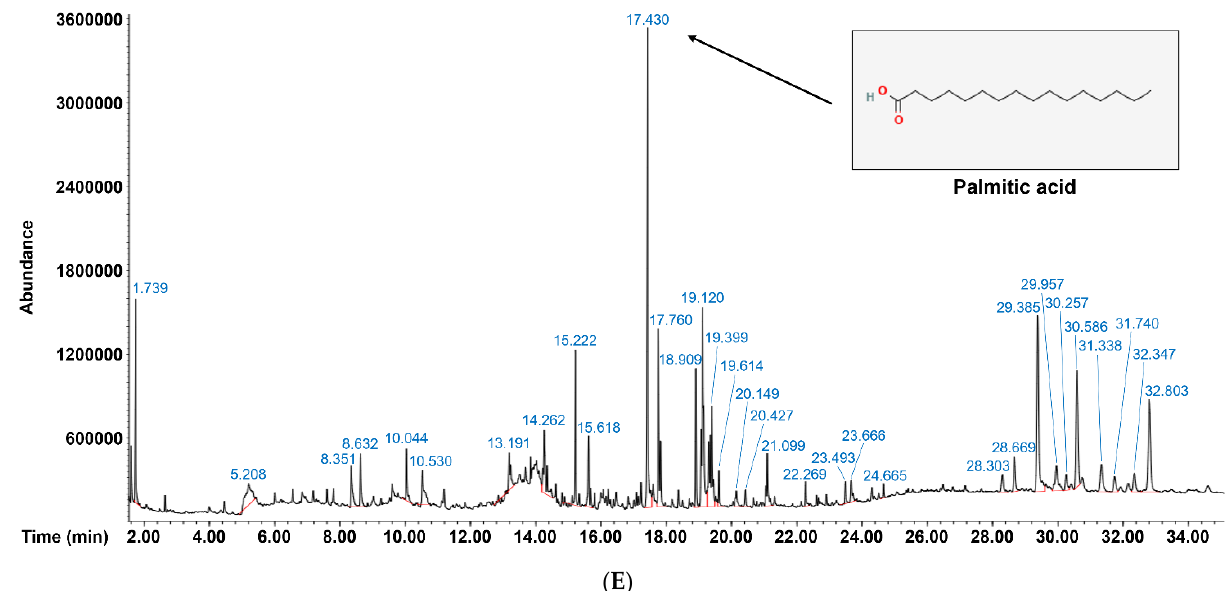
Figure 1. Inhibitory activity of Gt-EE on degranulation of RBL-2H3 cells and the phytochemical components of Gt-EE. ( A ) The cytotoxicity of Gt-EE to RBL-2H3 cells was determined using the MTT assay. RBL-2H3 cells were treated with Gt-EE for 24 h, and then cell viability was determined. ( B – D ) The degranulation of stimulated RBL-2H3 cells was investigated by establishing the amount of β -hexosaminidase released. ( B ) IgE-sensitized RBL-2H3 cells were treated with Gt-EE for 30 min and then challenged with DNP-HSA for 24 h. ( C ) RBL-2H3 cells were stimulated with PMA/A23187 for 1 h. ( D ) RBL-2H3 cells were degranulated by compound 48/80 for 1 h. The amount of β -hexosaminidase secreted was evaluated using a β -hexosaminidase activity assay; ( E ) the GC-MS chromatogram of Gt-EE. A phytochemical fingerprinting profile of this extract was obtained by GC-MS analysis. ( A – D ) are presented as the mean ± standard deviation. ## p < 0.01, ### p < 0.001 compared with the normal group, and ** p < 0.01, *** p < 0.001 compared with the control group.